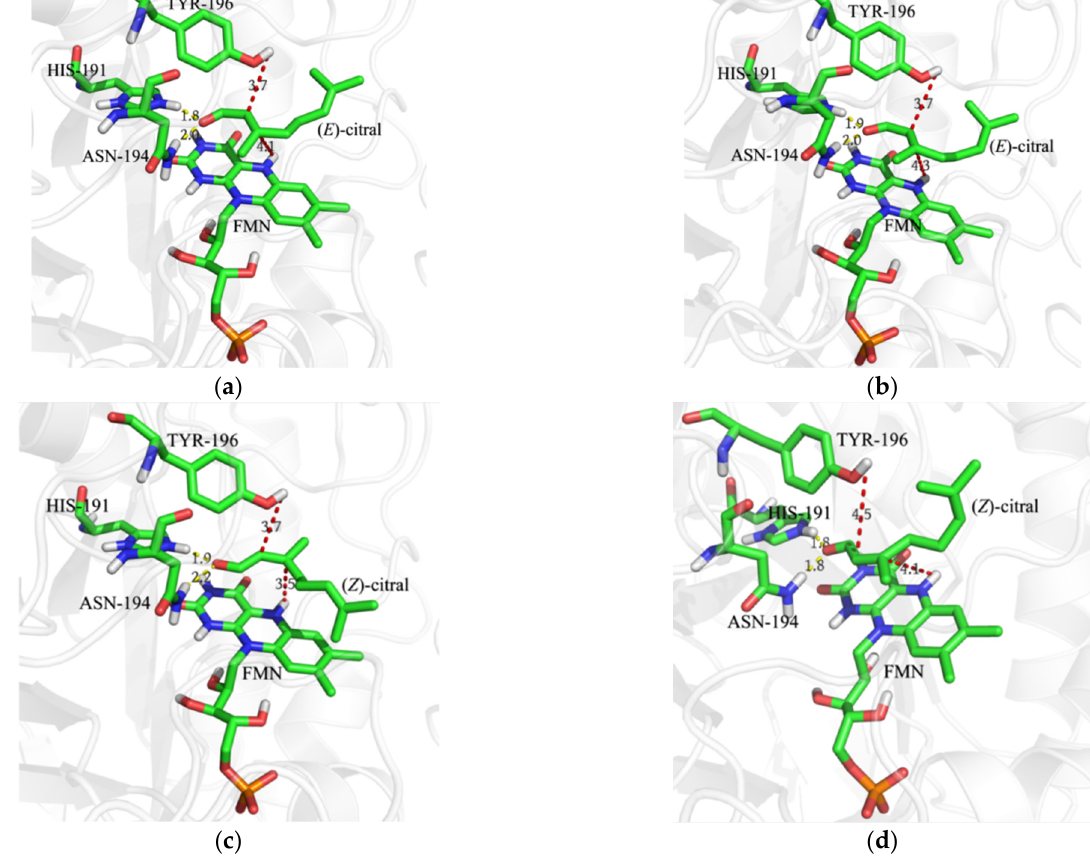
Figure 2. The docking analysis of the difference of OYE3 and its variant S296F/W116G on the utilization of citral isomer. ( a ) OYE3 and ( E )-citral; ( b ) S296F/W116G and ( E )-citral; ( c ) OYE3 and ( Z )-citral; ( d ) S296F/W116G and ( Z )-citral. Green, carbon atom; blue, nitrogen atom; tangerine, oxygen atom; white, hydrogen atom; orange, phosphorus atom.